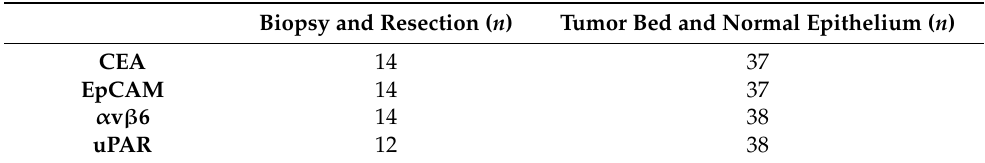
Table A2. Available stained tissue “pairs” per